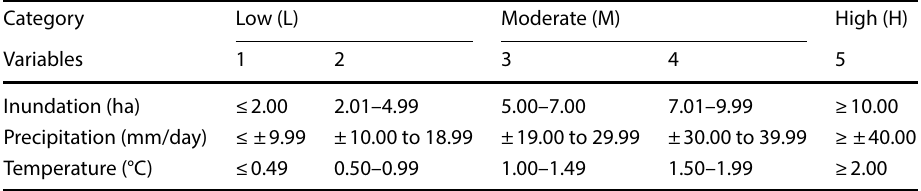
Table 2 Scoring of exposures based on inundated area and changes in precipitation temperature